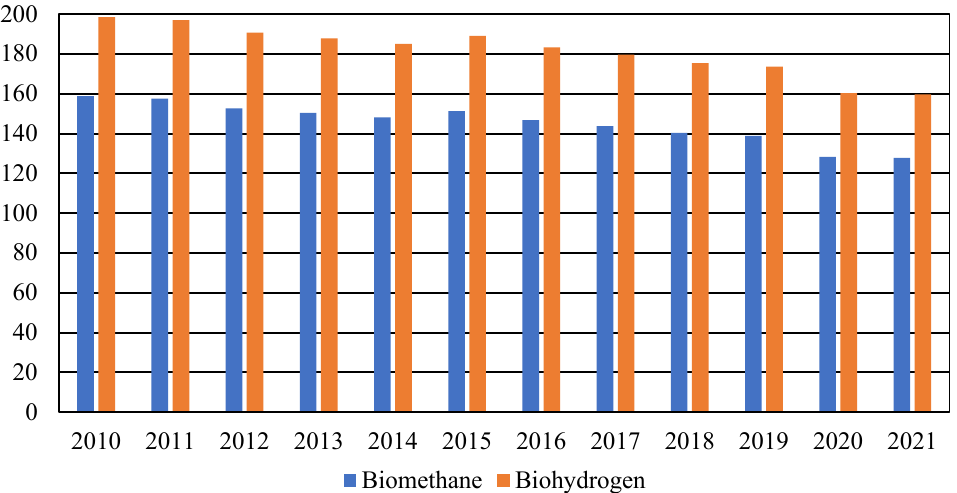
Figure 10. The potential of biomethane and biohydrogen production from livestock by-products (mln. m 3 ). Taking into consideration the average calorific value of biomethane—33 . . . 34 MJ/kg—